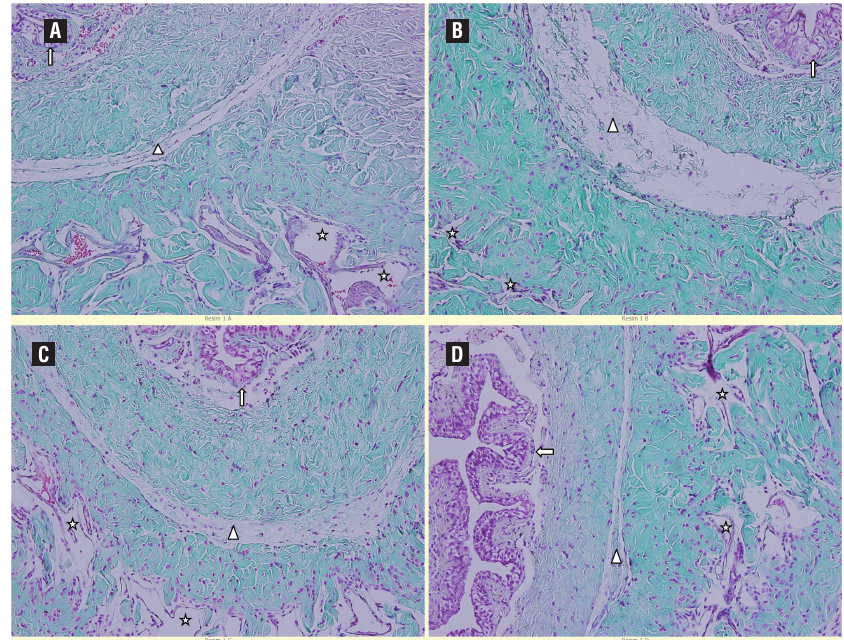
Figure 3 - Histopathological examination of the penis from each experimental group (Masson’s trichrome staining x200). a: group 1, b: group 2, C: group 3, D: group